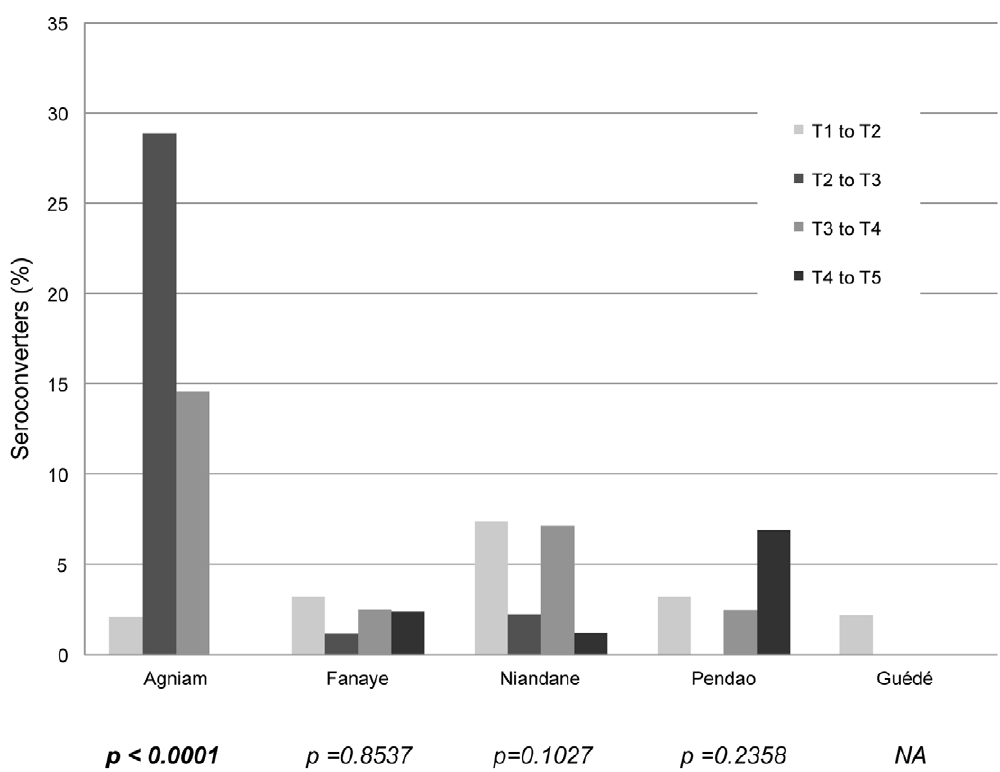
Figure 3. Seroconversion throughout the visits in each village. Chi-square test between number of seroconverters (sera becoming newly positive to PT) and rest of population from the village.